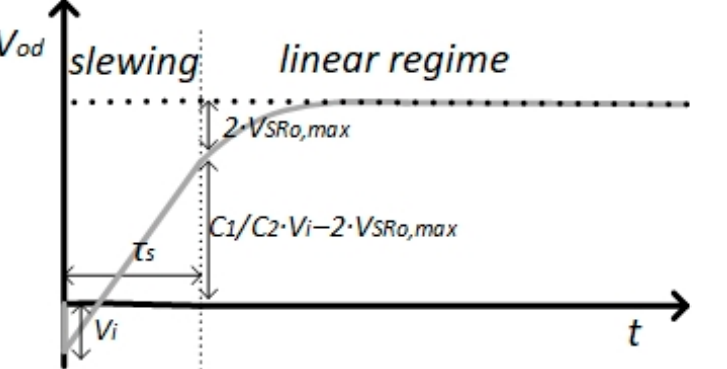
Figure 5. Output voltage behavior of the closed-loop switched-capacitor integrator including the slewing period.